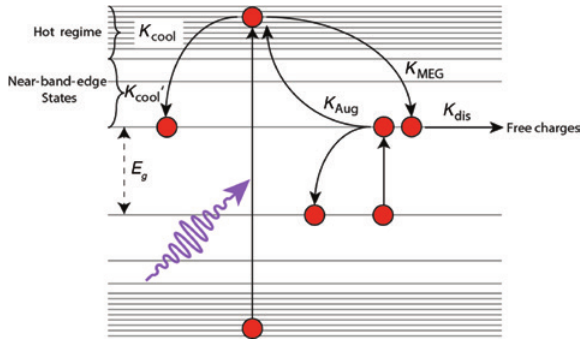
Figure 2: Schematics of the charge-carrier pathways of hot, photogenerated carriers in quantum-confined nanostructures on ultra-fast timescales ( < 1 ns). After generation, hot charge carriers can either relax to the band edge via rapid carrier cooling ( K ) or cool can undergo MEG ( K ). Due to discrete energy levels close to the MEG band gap and a more continuous state distribution higher up in the energy manifold, different hot carrier cooling behaviours can be expected in these two energy regimes which is expressed as ′ , respectively. If multiple excitons are generated they K and K cool cool either recombine via Auger recombination ( K ) or dissociate into Aug free charges ( K ), which can then be extracted. Recombination dis processes operating on longer timescales (e.g. trap-assisted and/or conventional bi-molecular recombination) are not considered